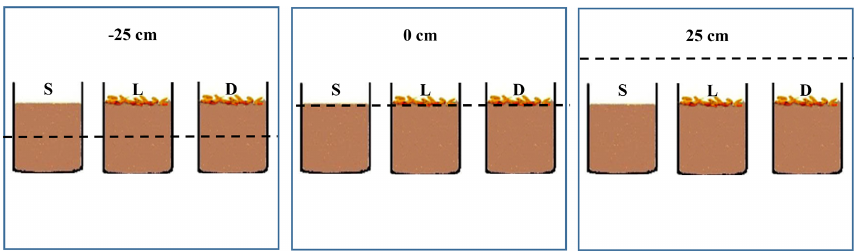
Figure 1. Schematic diagram of the experimental setup. The dotted line represents the water level. L represents litter which was distributed on the soil surface in 15 litter bags to observe the effects of leaf litter input on soil carbon pool; S represents soil which was designated the litter removal control; D represents decomposition which was distributed on the soil surface in 15 litter bags to monitor the litter decomposition rate and